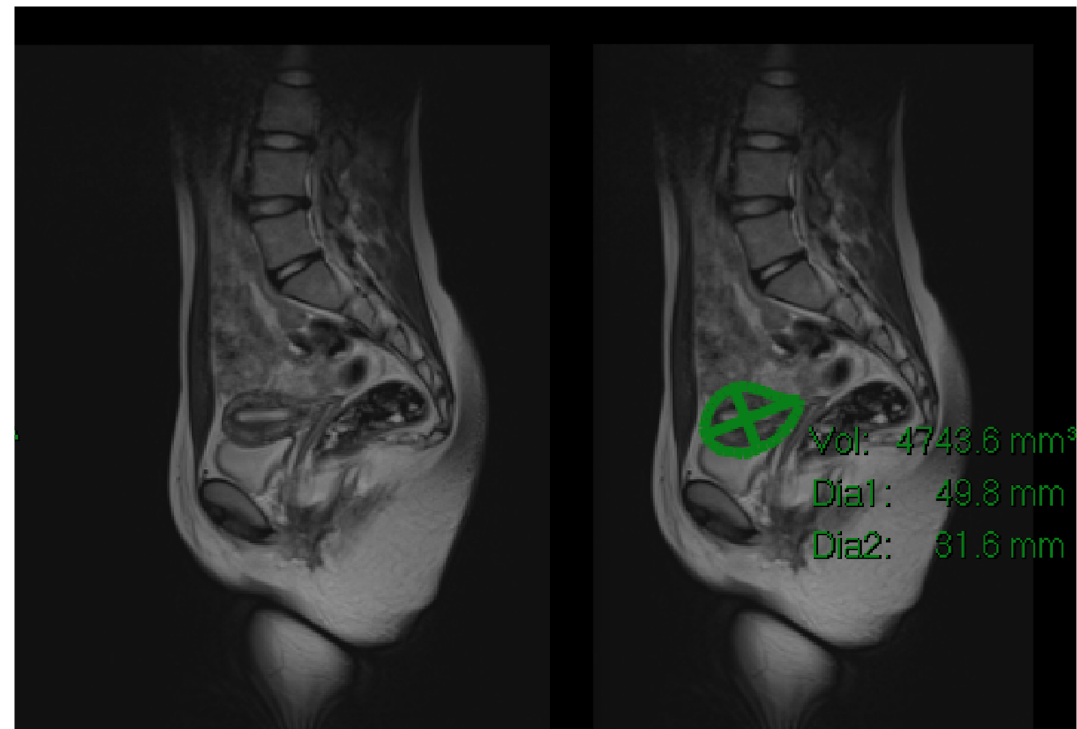
Fig 1. MRI pelvis with Sagittal T2 spin echo sequence demonstrating normal uterine morphology (left) with volume measurement (right) using a summation of area within the region of interest (ROI) from each contiguous image slice through the visualised